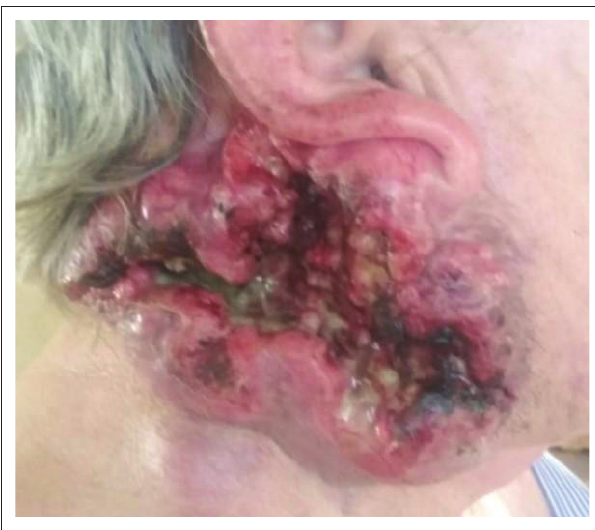
FIGURE 2: Short answer question clinical